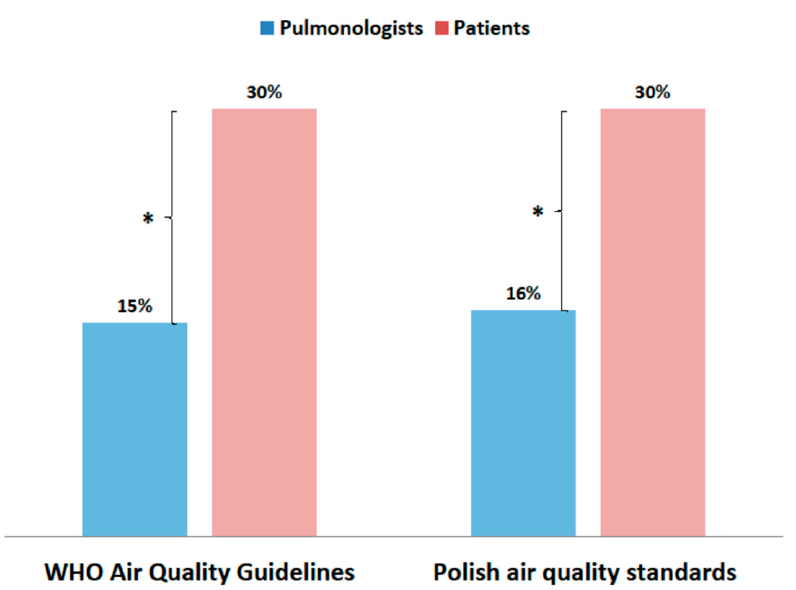
Figure 5. Declared knowledge of WHO and Polish air quality standards by patients and pul- monologists (* p < 0.001).